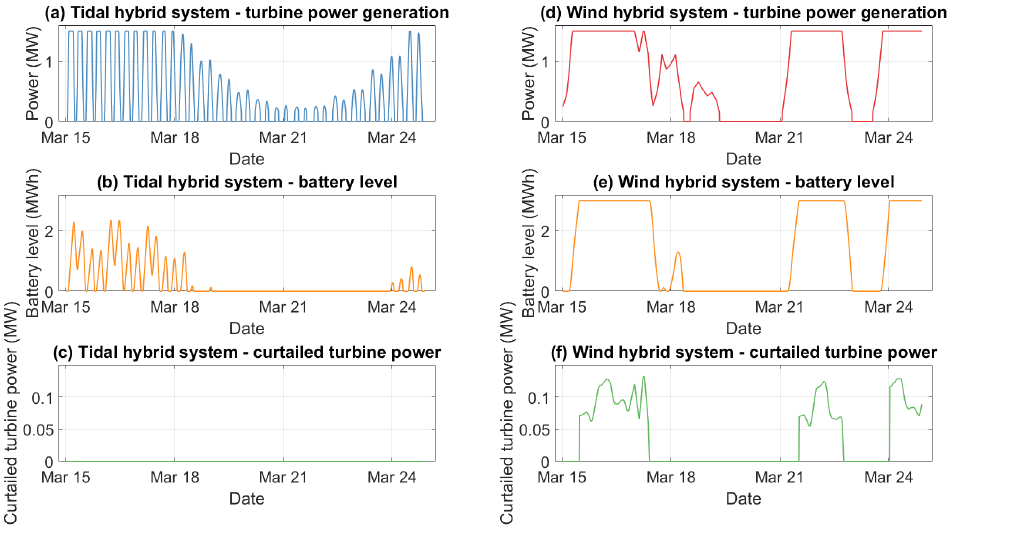
Figure 8. Overview of THS ( a – c ) and WHS ( d – f ), showing turbine power generation, battery level and curtailed power.